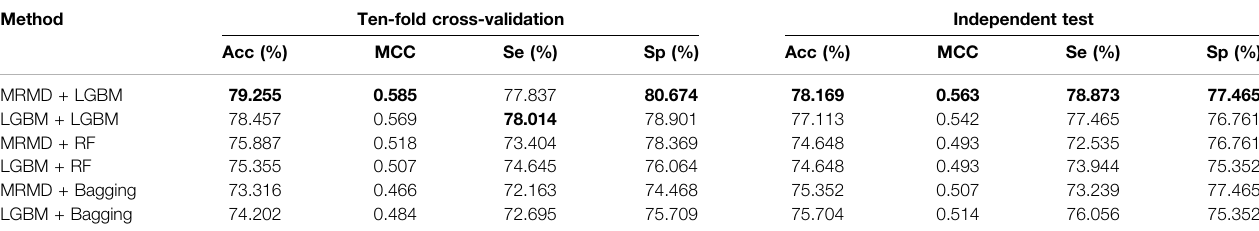
TABLE 3| Acomparison ofclassi fi cation results by apairwise combination oftwofeatureselectiontechniques (MRMD and LGBM) and three optimal classi fi ers (LGBM, RF, and Bagging). Method